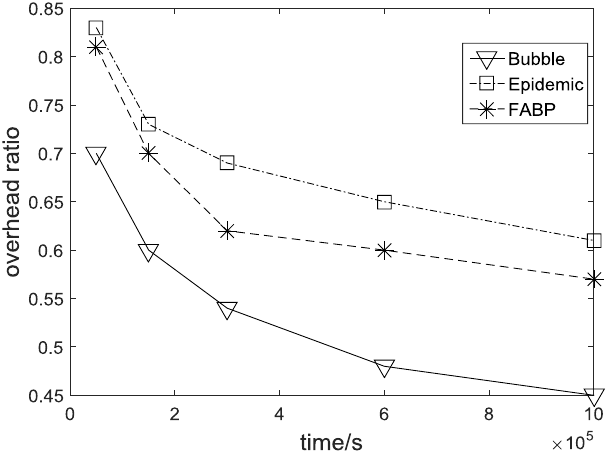
Figure 10. Comparison of the overhead ratio.